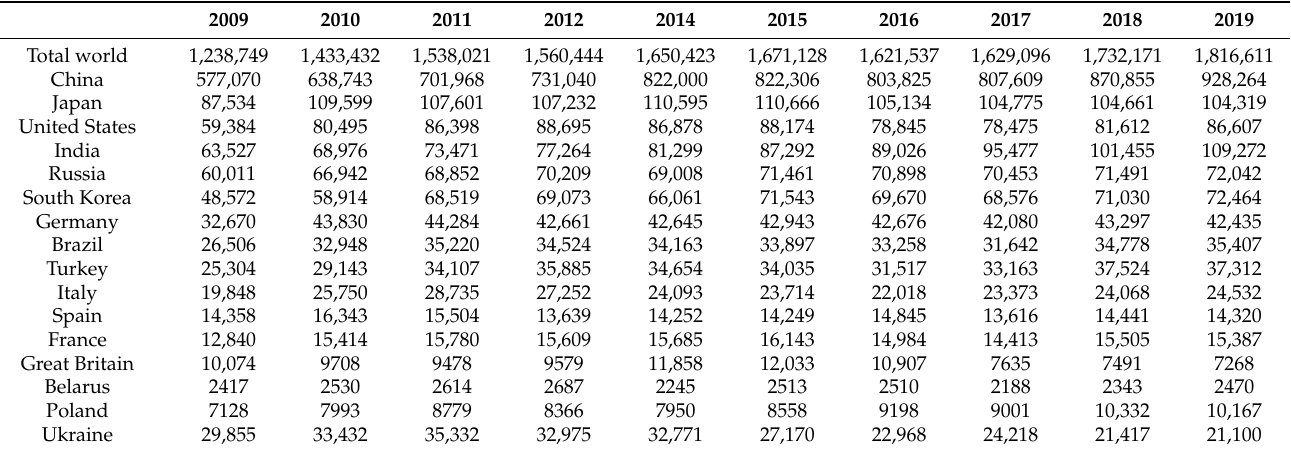
Table 1. Total production of steel products in thousands of tons